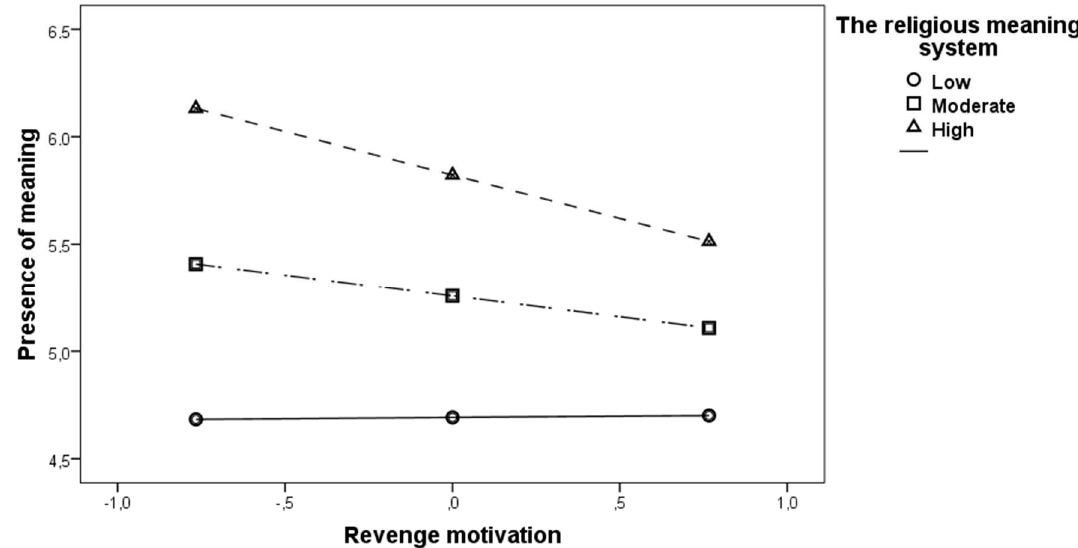
Figure 3. A visual representation of the moderation of the effect of revenge motivation on presence of meaning at low ( − 1SD), moderate ( M ), and high (+1SD) levels of the religious meaning system.